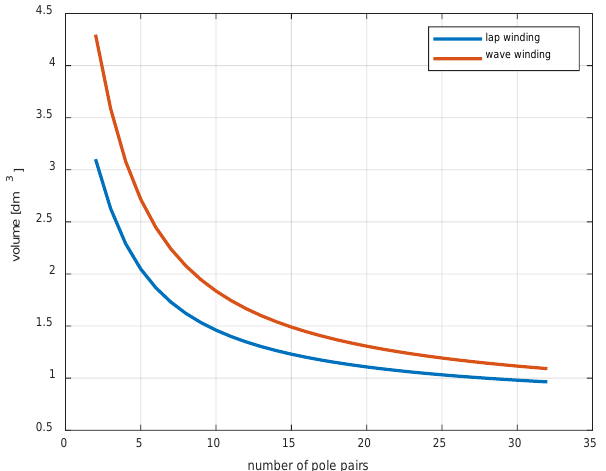
Figure 11. Volume of one CM segment as a function of the number of pole pairs for lap and wave windings.